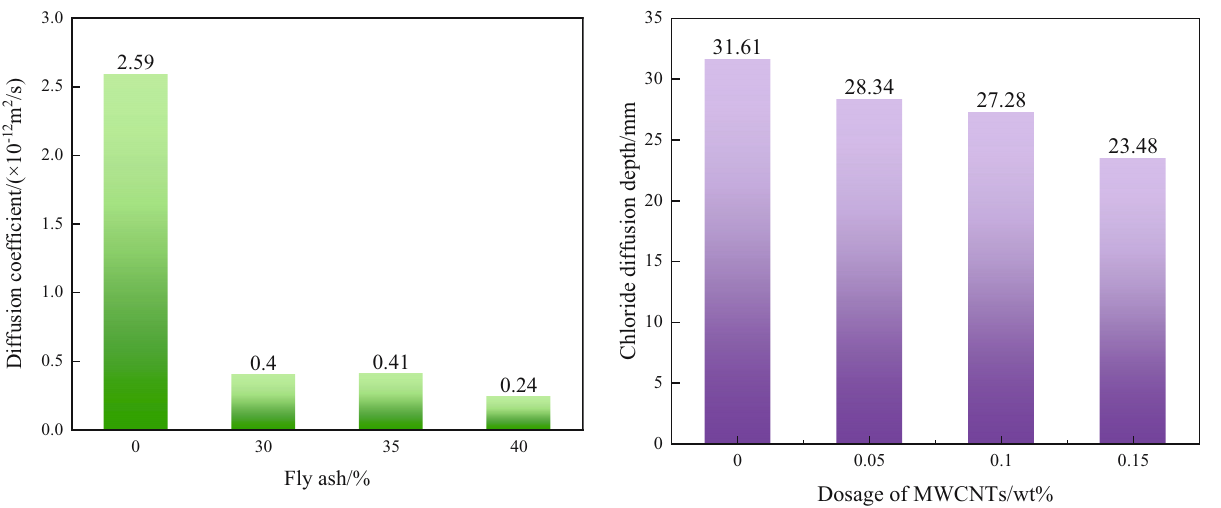
Figure 1: E ff ect of fl y ash on chloride di ff usion coe ffi cient of concrete [ 11 ] .